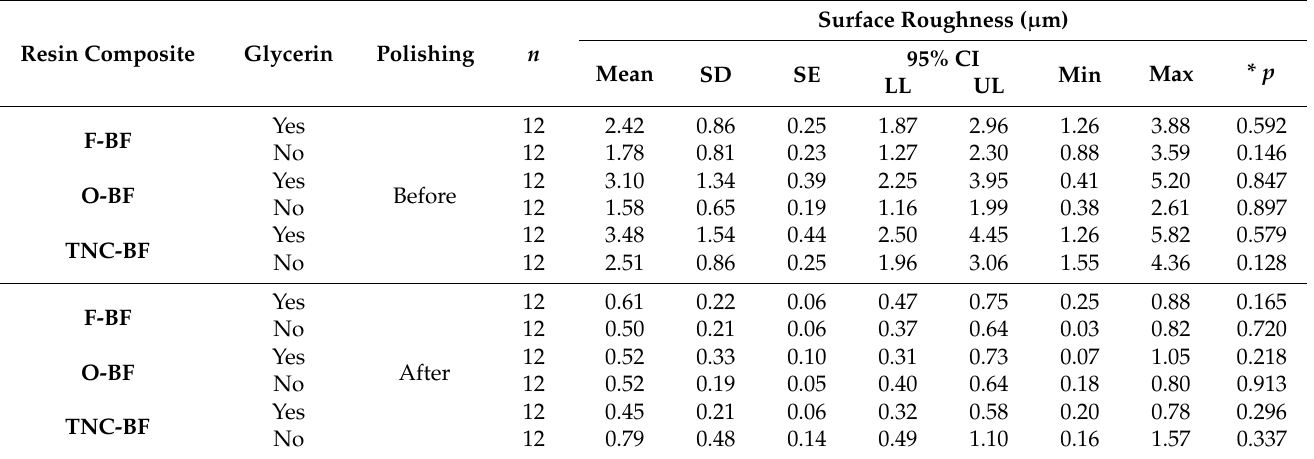
Table 2. Analysis of surface roughness values ( µ m) before and after polishing of bulk-fill resin composites with and without OIL control.